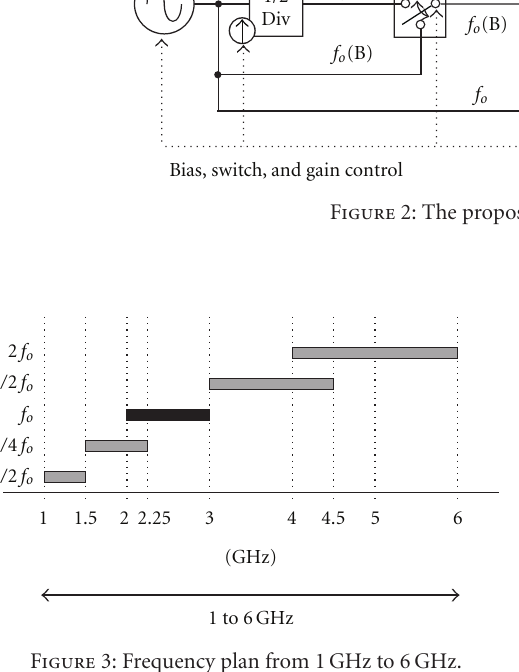
Figure 3: Frequency plan from 1GHz to 6